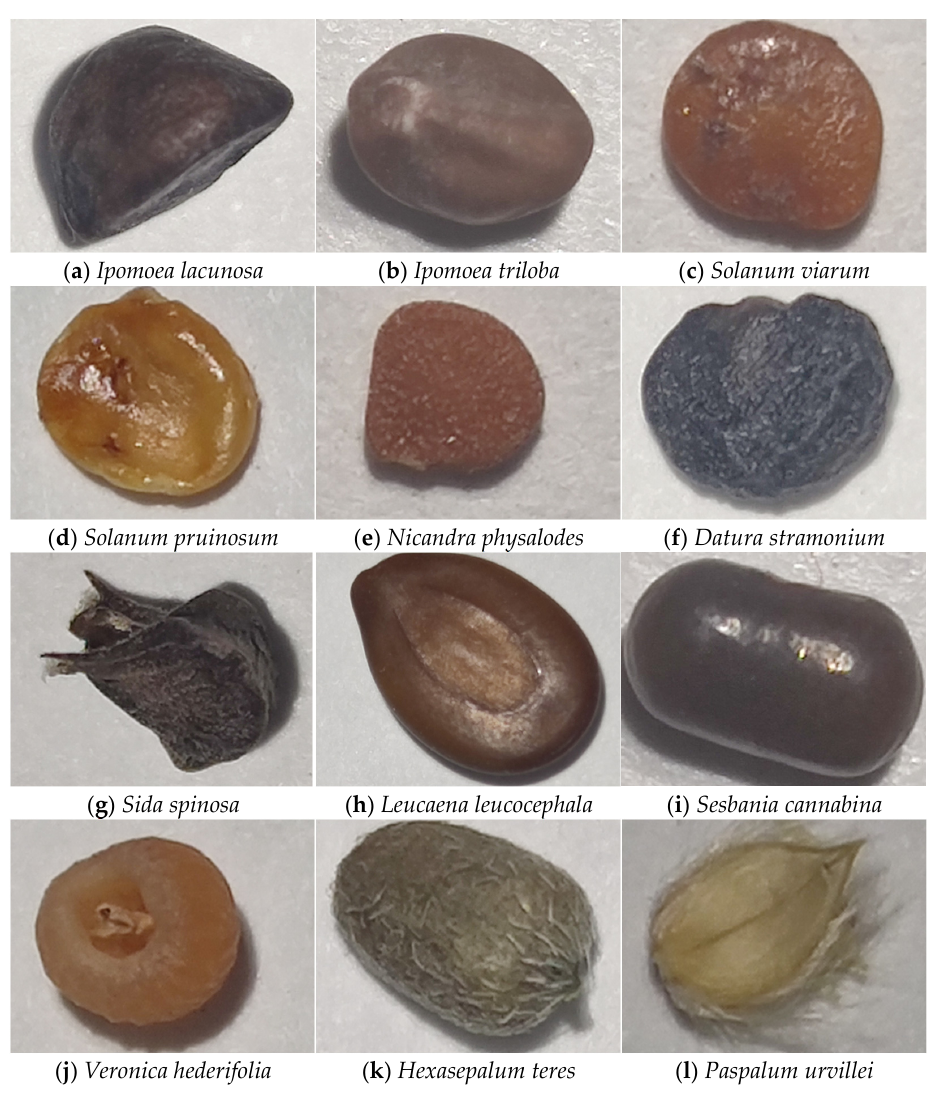
Figure 11. Screenshots of 12 species in the data set. When shooting the data set for the selected 12 species, we use the mobile phone macro lens (xiaomi10; 2 million pixels; F/2.4 aperture) to shoot the seeds under the light of 5500 K color temperature, which is more suitable for the application scenario of real-time quarantine of customs staff. To obtain more detailed features of seed appearance and improve the generalization ability of the data set, we used 5 × optical zoom and 10 × optical zoom to shoot seeds, respectively, taking 480 photos of single species and 520 photos of mixed species. Each picture contains a different number of targets, and some data sets are shown in Figure 12. Through random vertical and horizontal mirror flipping and random brightness adjustment, we expand the number of samples in the data set to three times the original image, a total of 3000 images and 14,682 targets. The target distribution of the 12 species is shown in Figure 13, and the target number of each species was evenly distributed. We used the LabelImg [31] data annotation tool to label the seed data, divide the data set into a training set, and test set according to a ratio of 4:1, and the picture resolution was 4344 × 3940.